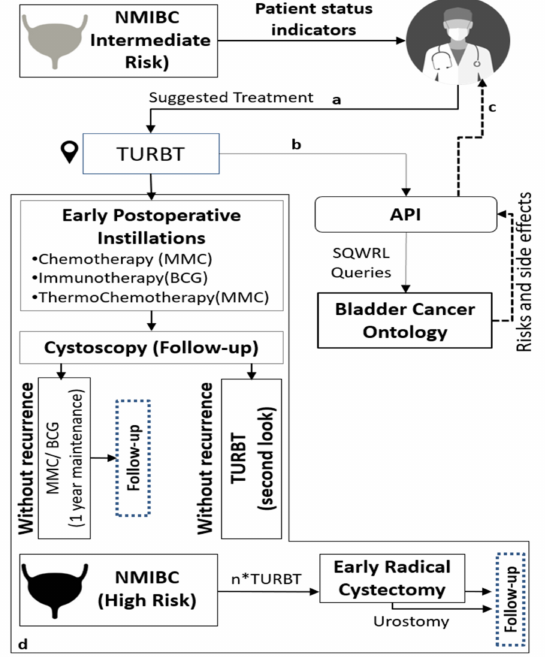
Figure 2. Case scenario of BC treatment process and the required generated SE prediction ap- proach; (a) Treatment suggested for evaluation; (b) Evaluation; (c) Prediction results for decision; (d) Treatment procedure following TURBT. Table 3. Predicted risks and side effects’ results related to the applied treatment.